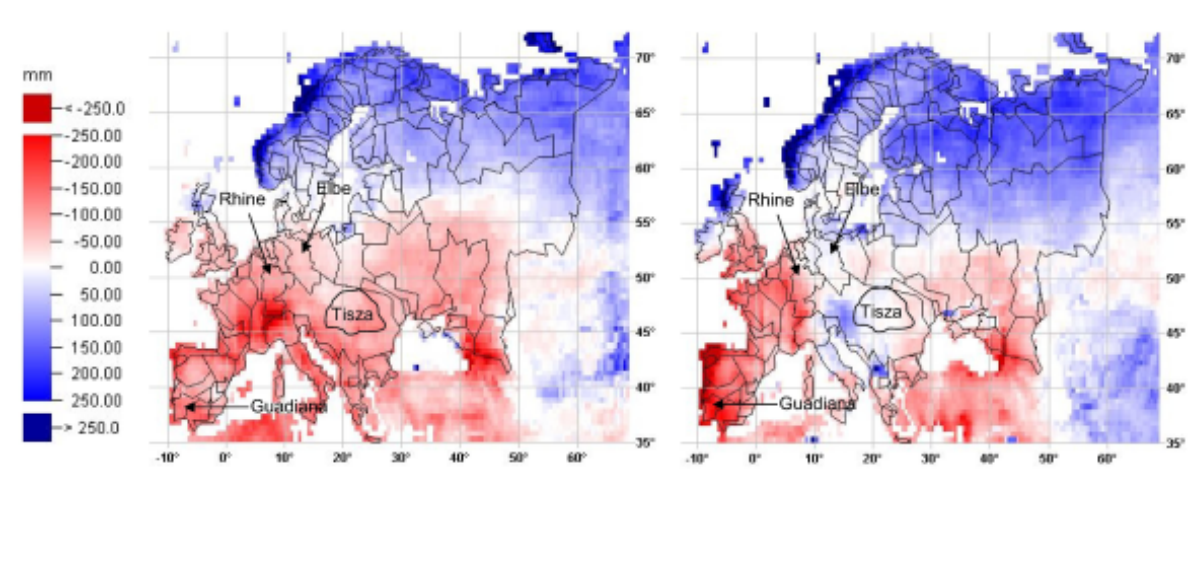
Fig. 1. Difference in average annual precipitation between scenario period 2041–2060 and reference period 1961–2000 as seen in climate models HadCM3 and ECHAM4 (resolution 0.5°). The basins are the Rhine, Elbe, Tisza, and Guadiana, and the lines define catchment